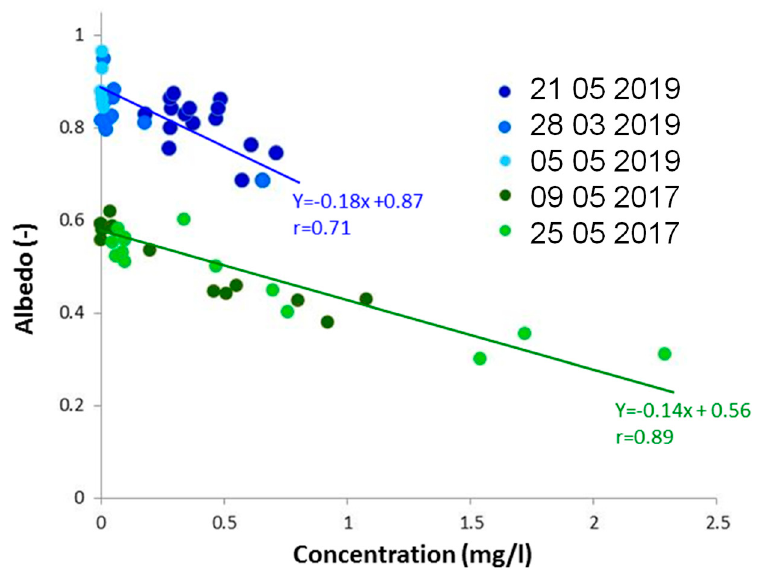
Figure 8. Scatter plot of broadband surface albedo and insoluble material concentration, with the linear adjustment between both variables. Green colored points correspond to 2016–2017 snow season and blue colors to the 2018–2019 snow season observations.